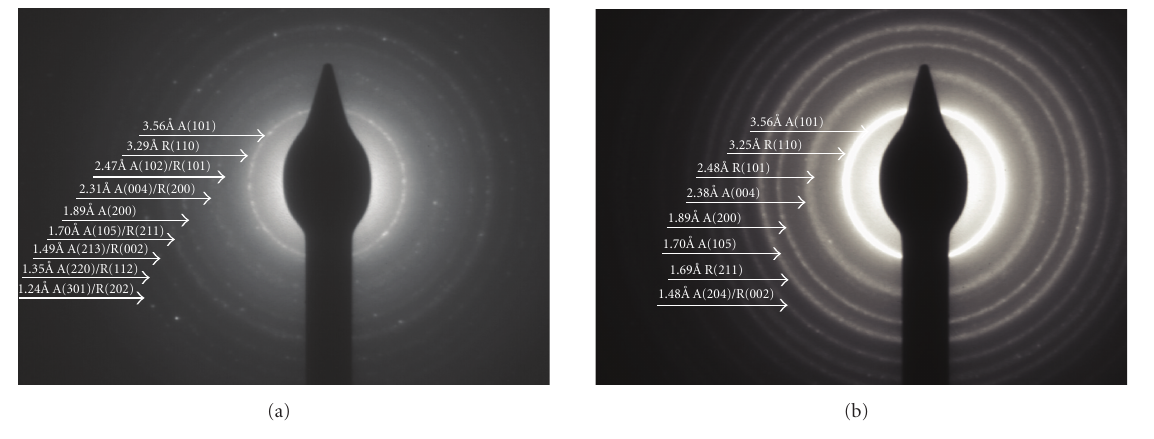
Figure 12: SAED patterns for samples S A and S0.